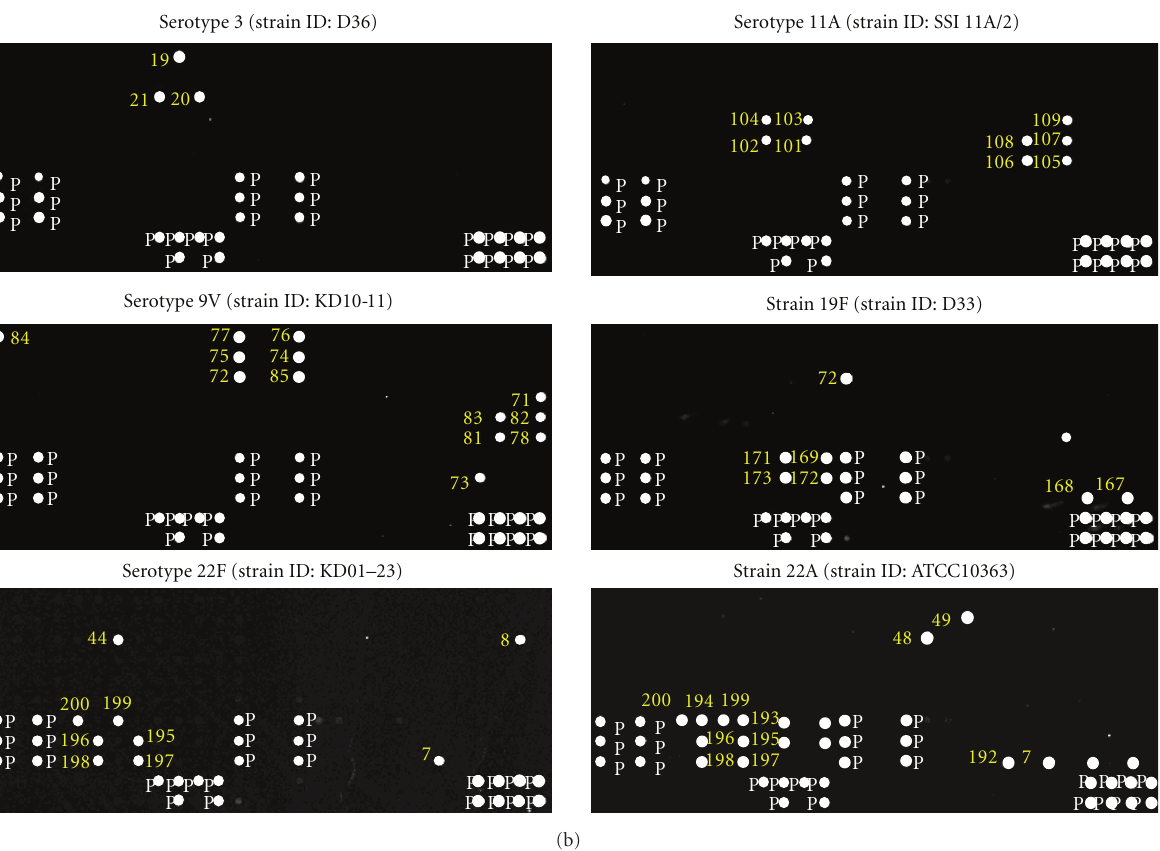
Figure 1: (a) Microarray oligonucleotide probes layout. Oligonucleotides 1 to 222 are provided in Tables 2 and 3. P represents S. pneumoniae housekeeping genes and 16S rDNA positive control oligonucleotides. N indicates negative control oligonucleotides designed from housekeeping genes of other bacterial species. E denotes empty spot. (b) Scanned microarray images of S. pneumoniae genomic DNA hybridized with 6 samples (serotype 3, 9V, 11A, 19F, 22F and 22A). The numbers correspond to the spot identifiers given in Tables 2 and 3, and Figure 1(a) P indicates positive